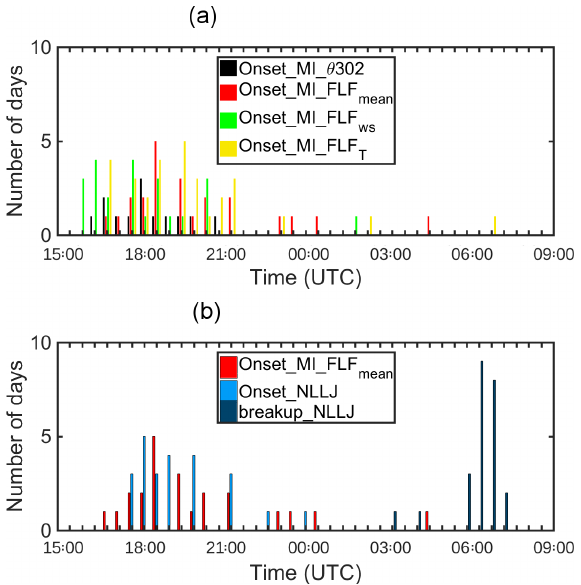
Figure 6. (a) Distribution of MI arrival times determined using the 302K potential temperature criterion and the fuzzy logic function method (FLF T , FLF ws , and FLF mean ) for the period between 1 and 30 July 2016. (b) Distribution of NLLJ onset and breakup times at Savè during the period from 20 June to 30 July 2016. The MI arrival times detected with FLF mean , already presented in panel (a) , are also indicated.